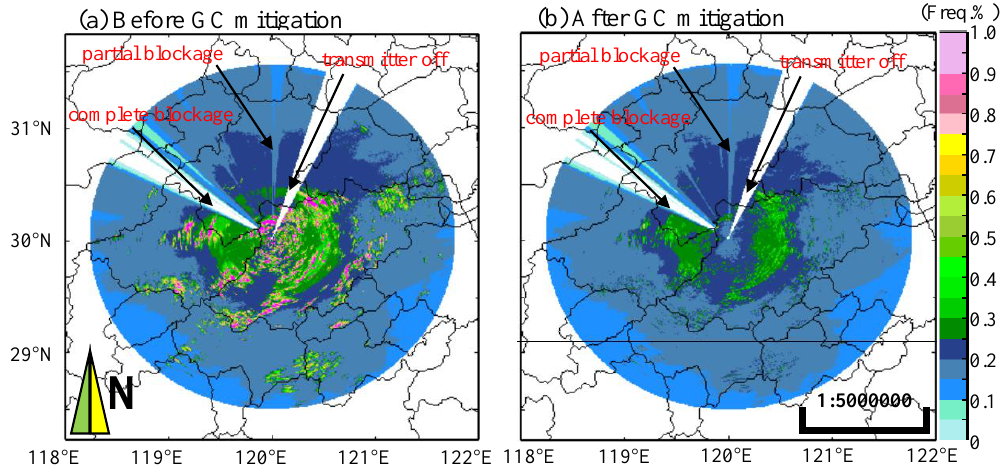
Figure 2. The relative frequency (Freq.%) of pixels with Z H > 20 dBZ within range of 180 km from the